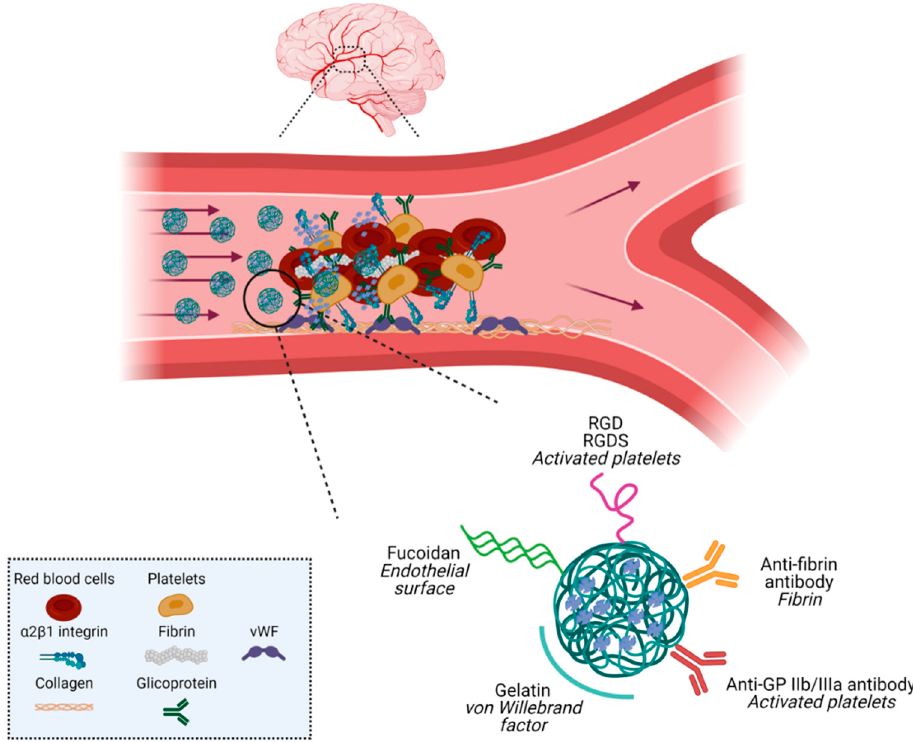
Figure 6. Strategies to target the nanosystems to the thrombus. Figure created with BioRen- der.com.